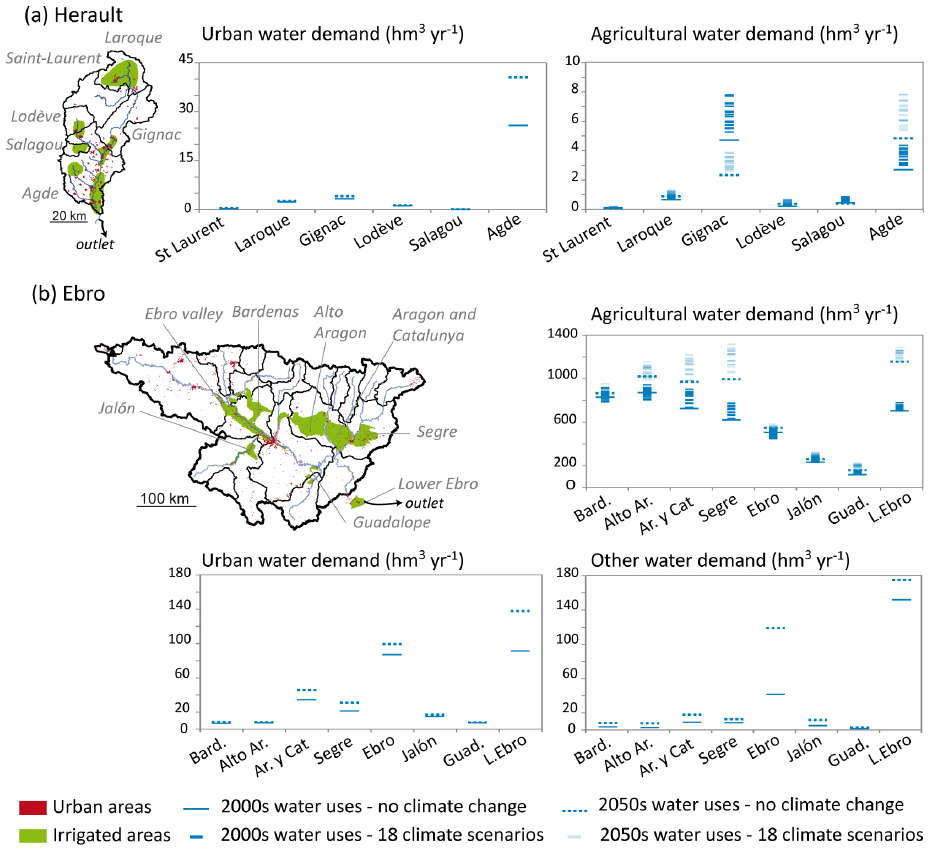
Figure 4. Water demands for human activities in (a) the Herault and (b) the Ebro basins under four combinations of water use and climate